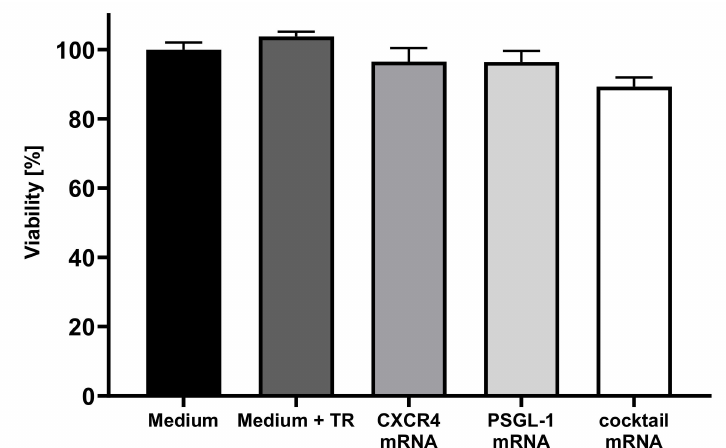
Figure 2. Analysis of cell viability of EPCs after transfection with CXCR4 and PSGL-1 mRNA. A total of 1 × 10 5 cells were seeded and transfected after 24 h with 1 µ g of CXCR4, PSGL-1 mRNA, or both mRNAs (mRNA cocktail). The viability was analyzed 24 h post-transfection using a PrestoBlue™ cell viability assay. The viability of cells incubated only with the medium was set to 100%. Results are shown as mean + SEM ( n =